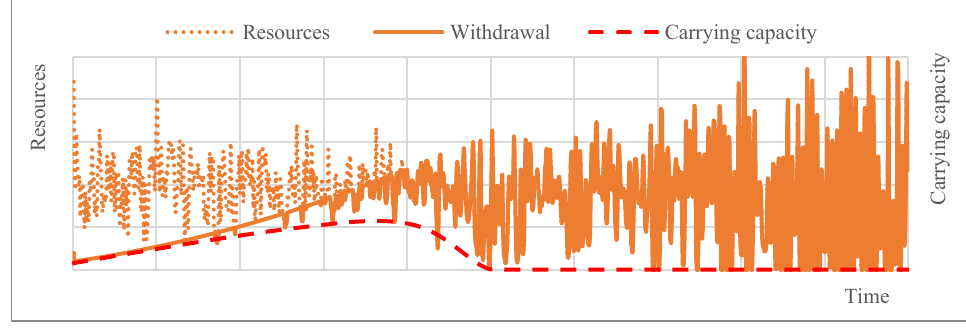
Figure 7. Toy model: The concept of environmental determinism with HK dynamics where storage and technology are increasing, but the available resources are not consumed sustainably.